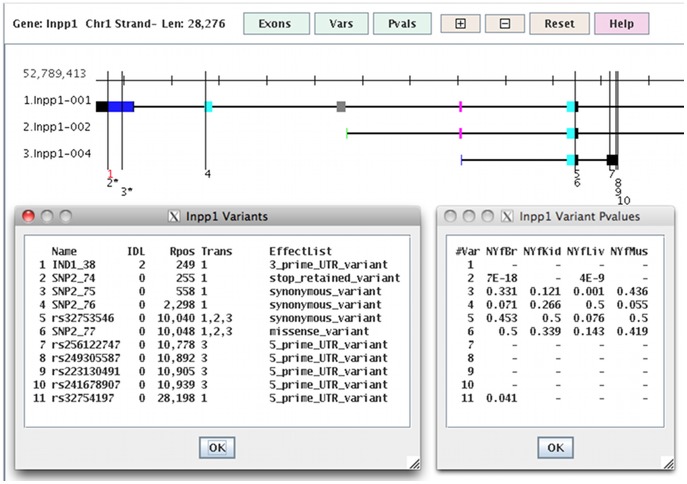
viewAW drawing of a gene with three transcripts and 11 variants.The black exons are non-coding. The coding exons that are stacked but are different colors have different coordinates, e.g. the stack with two pink exons (the same) and a blue (different). The long vertical lines represent SNPs (black) and indels (red); if the number below the variant line is followed by an “*”, then it is AI (p-value <0.05) for at least one library, e.g. variant #2 is AI for libraries NYfBr and NYfLiv.